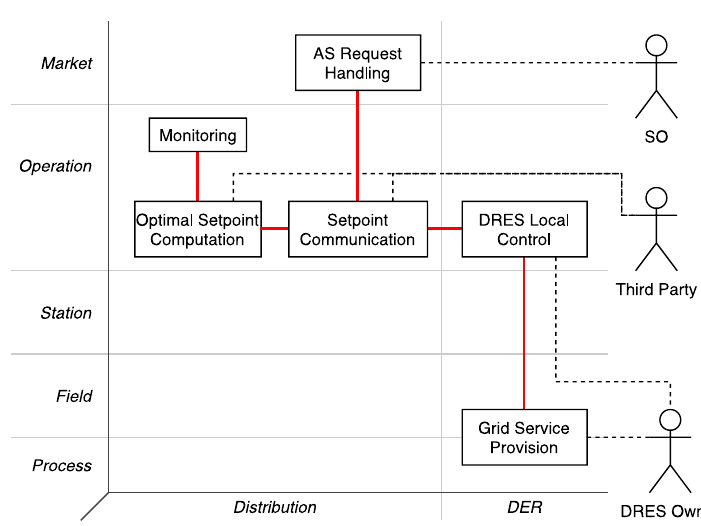
Fig. 2 Function layer of the proposed